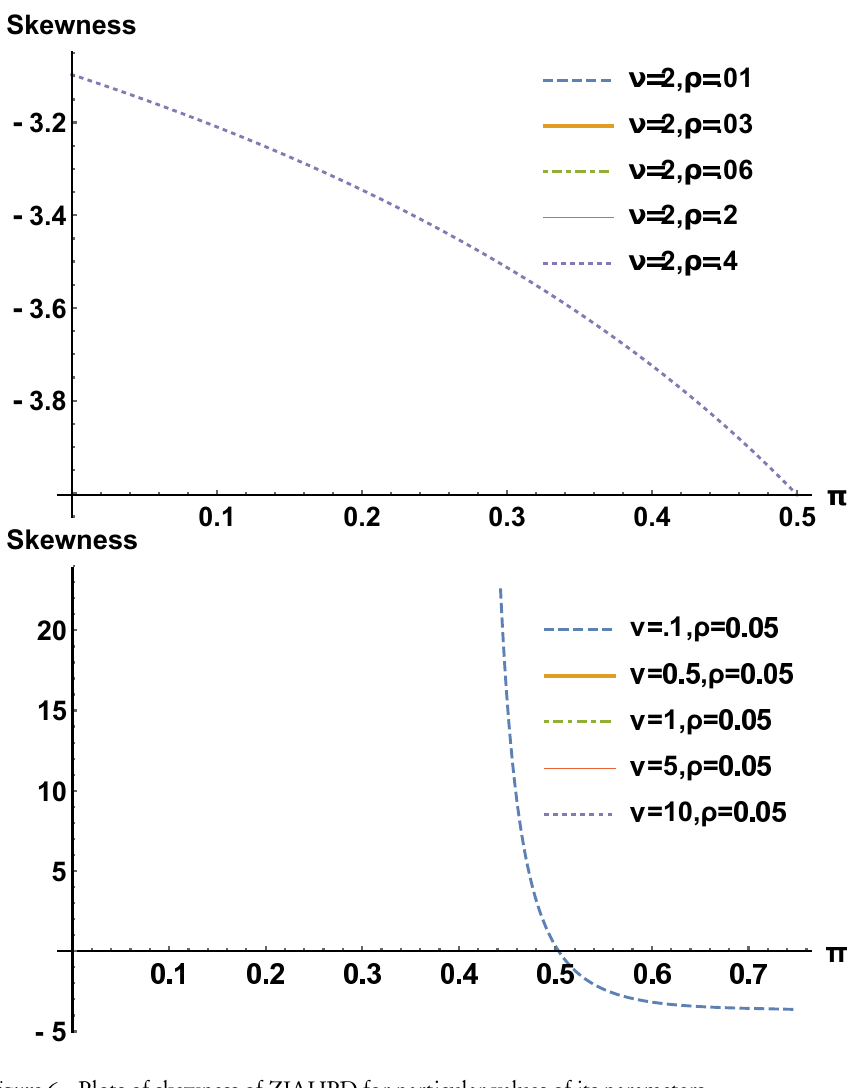
Figure 6 – Plots of skewness of ZIAHPD for particular values of its parameters.